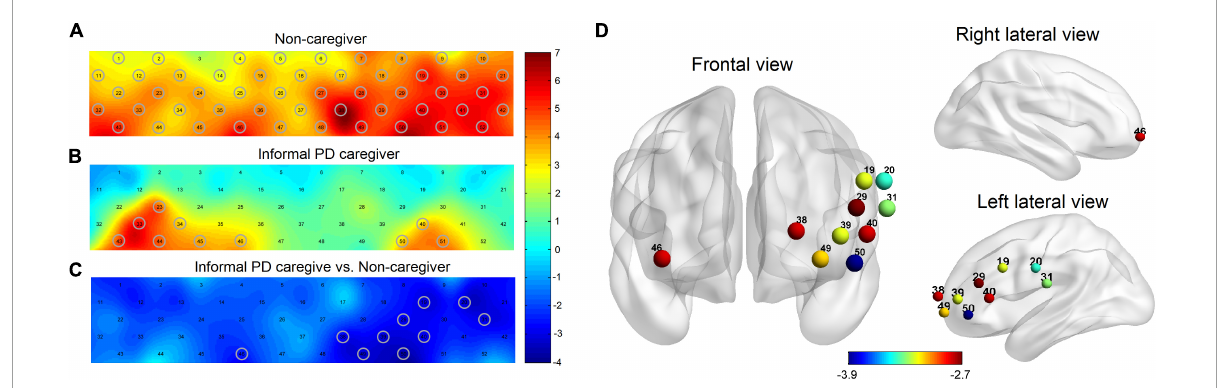
FIGURE2 Brain activation maps of oxy-Hb level in non-caregiver and informal PD caregiver during VFT. (A) Brain activation during VFT for non-caregiver; (B) brain activation during VFT for informal PD caregiver; (C) the group comparison for brain activation between the informal PD caregiver and non-caregiver; red/yellow/green represents positive activation and blue represents negative activation in the (A − C) . (D) The locations of the corresponding brain regions of the significant channels in (C) , red to blue represents the increasing degree of negative activation. Gray cycles are utilized to label channels that achieve statistical significance. All p < 0.05, FDR corrected.